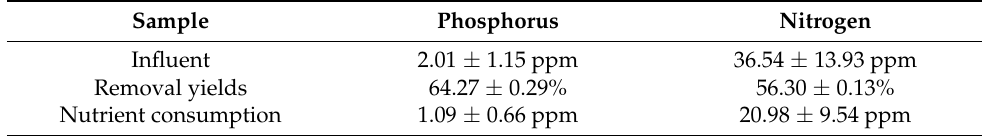
Table 8. Results of nutrient